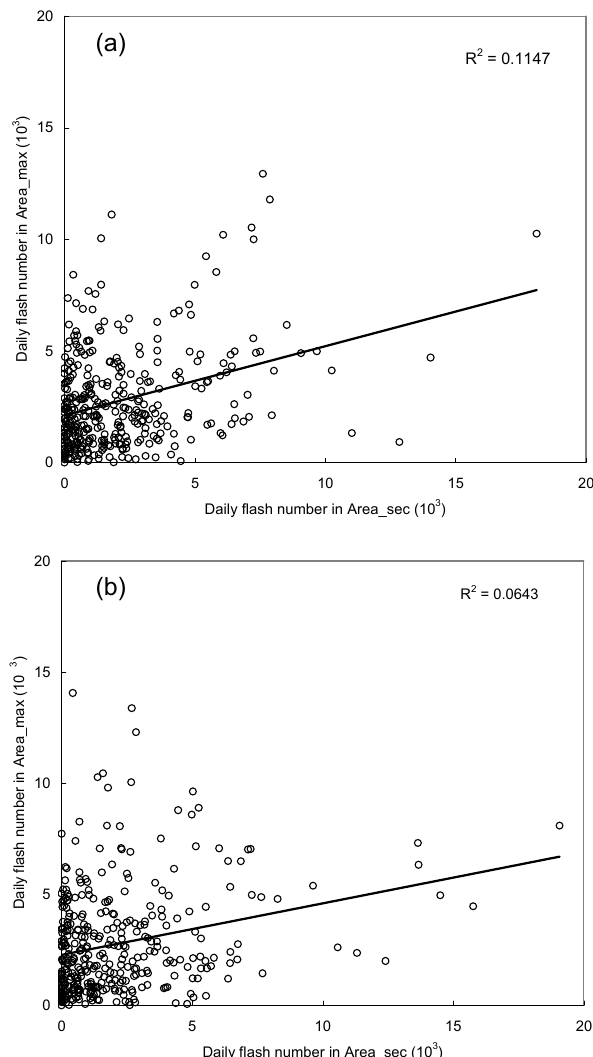
Figure 5. Diagrams of correlation between daily numbers of light- ning flashes for Area_max and Area_sec in 2013: (a) at calendar daily scale (00:00–24:00UTC) and (b) at lightning activity daily scale